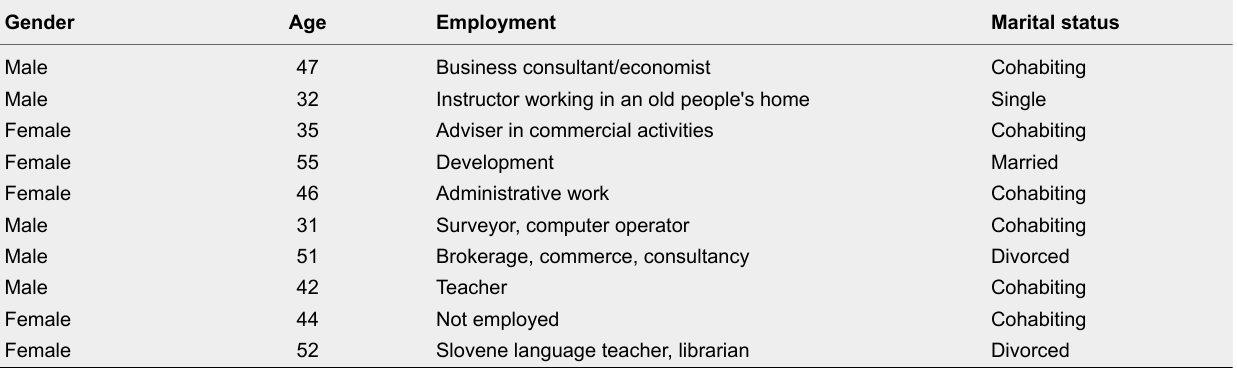
Demographic Characteristics of Participants From the Urban Environment Gender